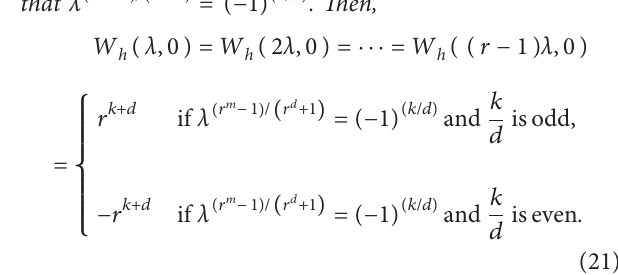
for Corollary 2 (ii).